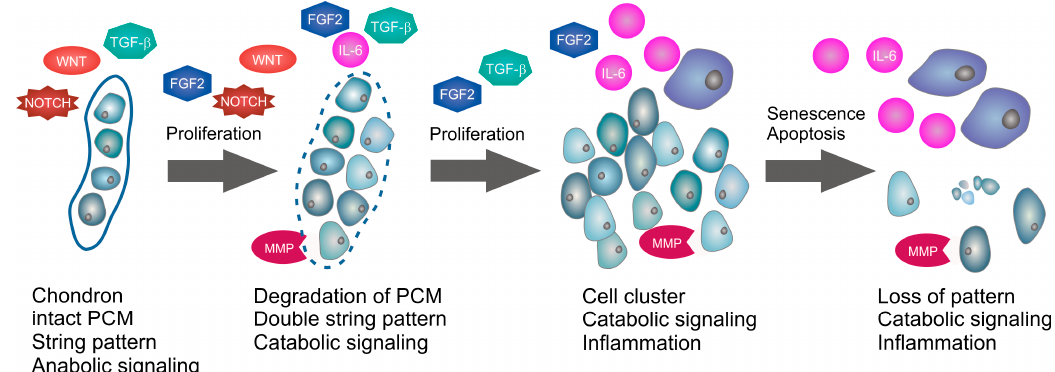
Figure 1. Human osteoarthritis onset and progression. Illustration of the relationship of signaling and superficial cell spatial organization (SCSO). Overview about key proteins in relation to changes in the SCSO of human articular cartilage (AC), which is based on the subsequent chapters that provide a detailed review of the individual pathways. In the superficial zone (SZ) of normal human adult AC differentiated chondrocytes are arranged in string patterns embedded in the pericellular matrix (PCM) and mediate extracellular matrix (ECM) maintenance. The onset of osteoarthritis (OA) is characterized by proliferation. During formation of double string patterns, the PCM is progressively degraded, presumably by MMPs and other catabolic factors. Proliferation in early OA is dependent on fibroblast growth factor 2 (FGF2), transforming growth factor β (TGF ‐β ), wingless ‐ type MMTV integration site family (WNT), and notch homolog (NOTCH) signaling, whereas catabolic matrix metalloproteinase (MMP) expression is mediated by FGF2, a switch in TGF ‐β signaling and inflammatory cytokines including IL ‐ 6. Subsequently, the processes maintaining sustained proliferation and ECM degradation lead to formation of cell clusters that develop from double strings. At the stage of SCSO clusters, pronounced inflammation outweighs attenuated growth factor impact. Late stage OA, accompanied by macroscopic ECM erosion, is characterized by senescence and apoptosis of cartilage ‐ inherent cells and predominance of inflammation.